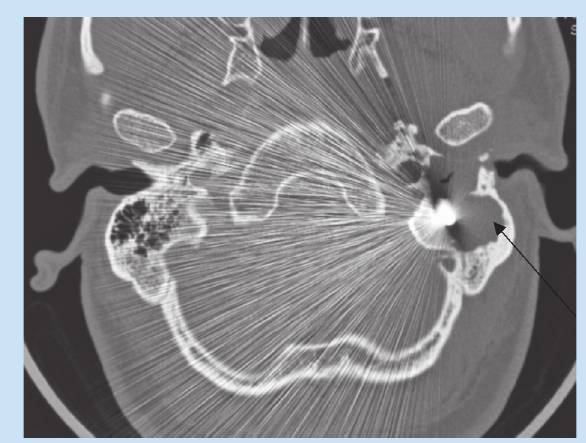
Fig. 5. Axial CT displaying a bullet lodged in the mastoid secondary to the old trauma. Note the cholesteatoma extending into the mastoid (arrow).